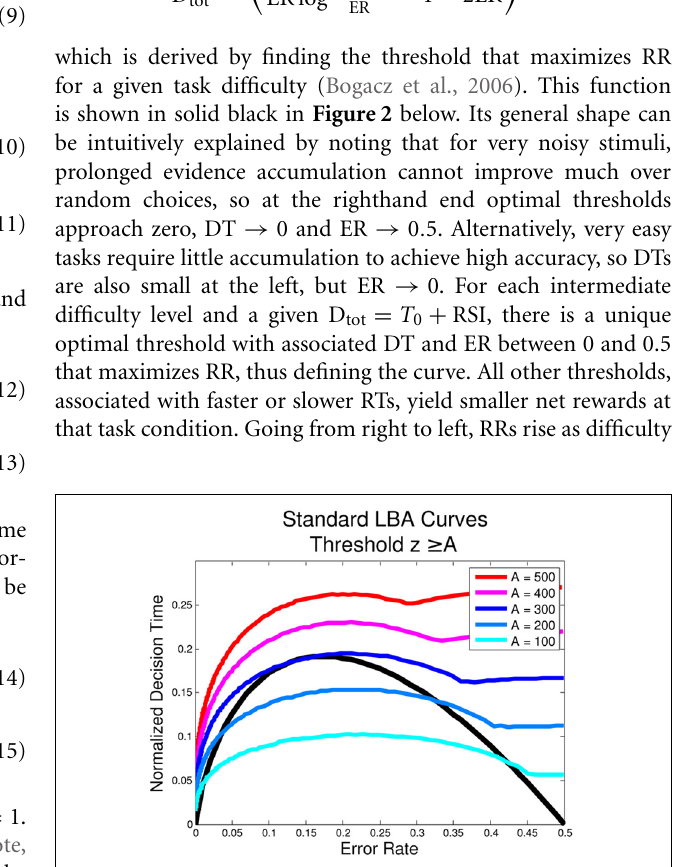
FIGURE 2 | Optimal Performance Curves (OPCs) for the LBA are not unique. The following parameters for the standard LBA were used in